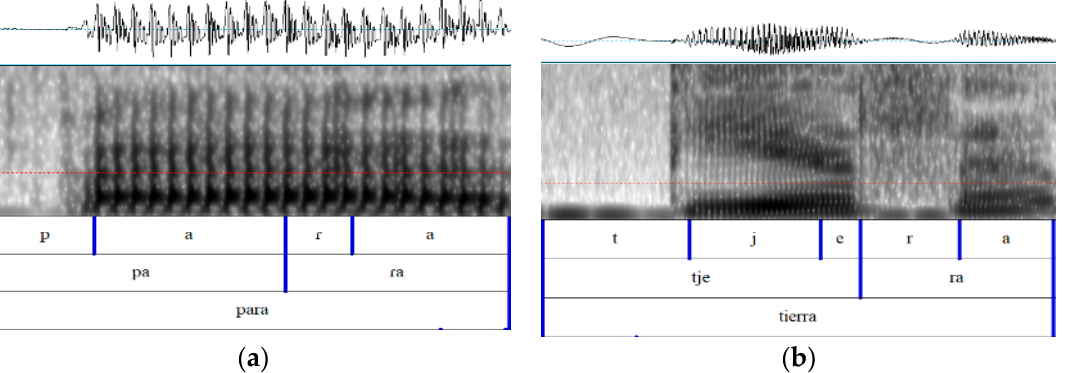
Figure 2. Intervocalic phonemic tap and trill containing ( a ) a perceptual apical occlusion for para ‘for’ and ( b ) an assibilate apical occlusion for tierra ‘earth’.